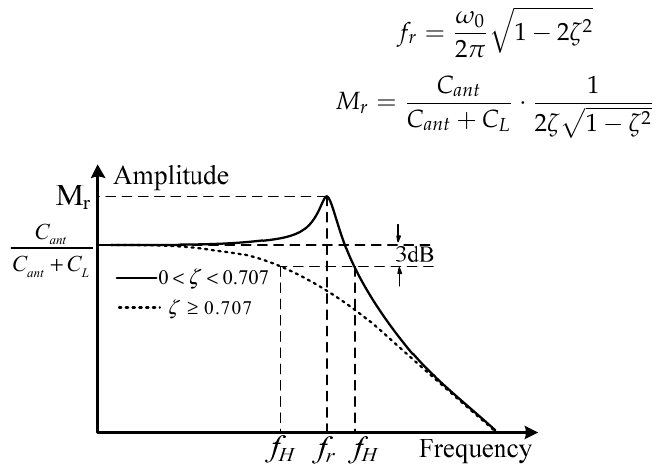
Figure 6. High frequency response curve.